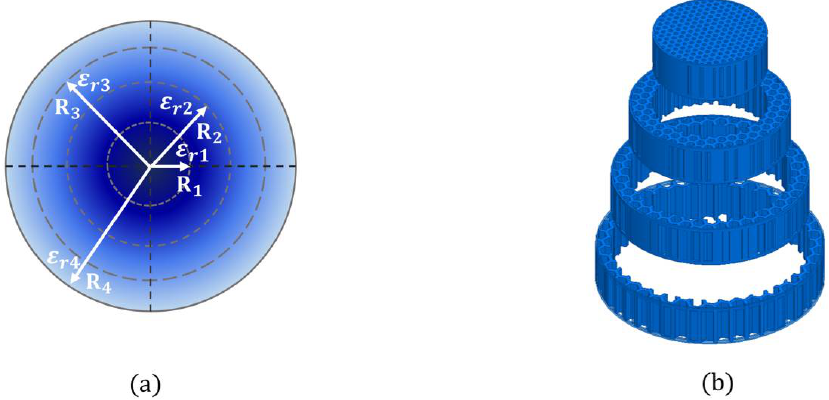
Figure 1. Proposed GRIN lens concept: ( a ) four-layer cylindrical GRIN lens, and ( b ) 3D-printed GRIN lens with honeycomb unit cells.